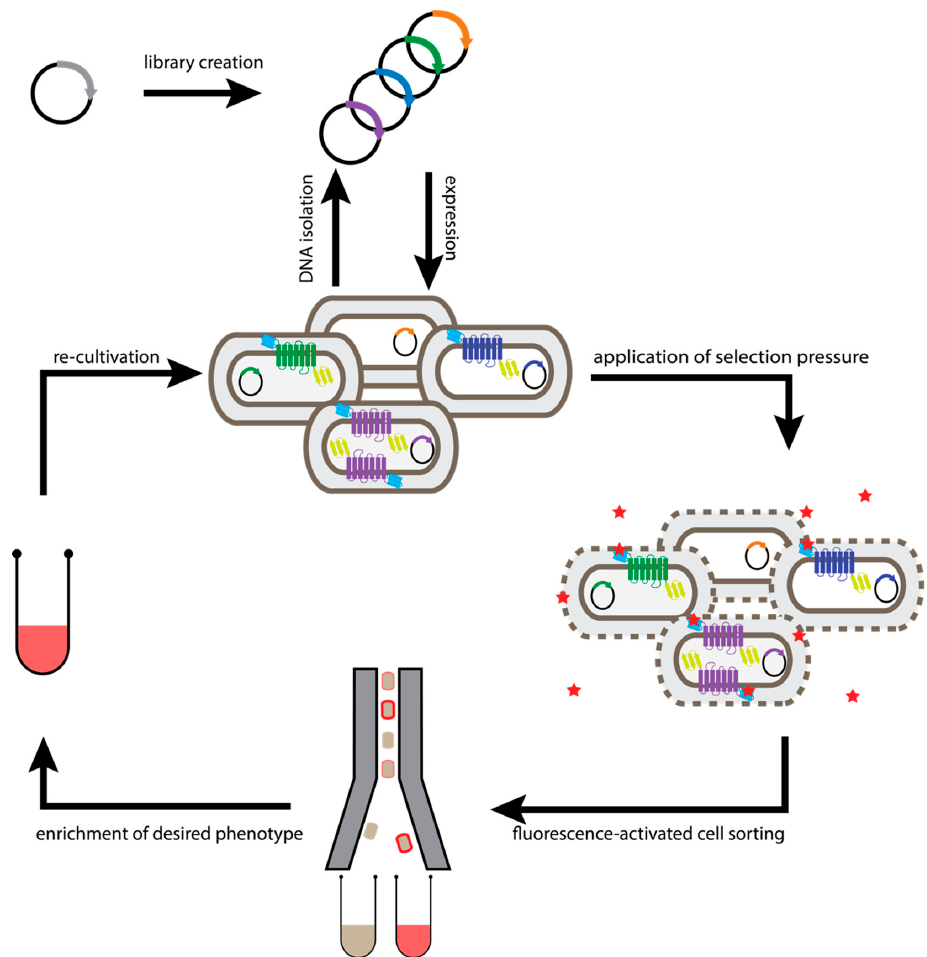
Figure 2. Workflow of generic selection of GPCRs. Evolution of GPCRs is initiated by diversification of the receptor gene. To enable ligand-independent assessment of surface expression, the receptor is fused N-terminally to a fluorogen-binding protein (cyan bars) and C-terminally to a fluorescent protein (yellow bars). The resulting DNA library is used for transformation of E. coli cells, so that each cell takes up at most one plasmid molecule. Subsequently, one receptor variant is expressed in the inner membrane of a single cell. After incubation with a fluorogen (e.g., malachite green attached to a short polyethylene glycol (PEG) molecule that makes it cell-impermeable, red star), its fluorescence greatly increases and cell surface expression levels determine the number of bound fluorophores, and the cells exhibiting the highest fluorescence (i.e., cells with the highest GPCR expression) are enriched by FACS. Sorted cells were propagated in growth medium. Re-grown cell pools can either be subjected to additional rounds of selection or plasmids can be isolated for analysis of individual